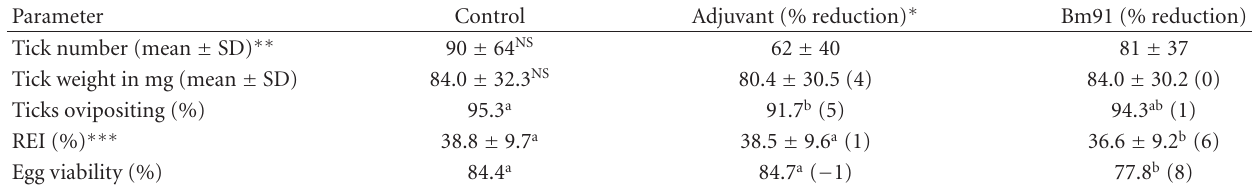
Table 1: Number, weight, oviposition, and hatching of naturally infested R. (B.) microplus ticks collected from Bos indicus cattle immunized with the antigen Bm91 and injected with saline (control) and adjuvant, respectively ( N = 6). Parameter Control Adjuvant (% reduction) ∗ Bm91 (%